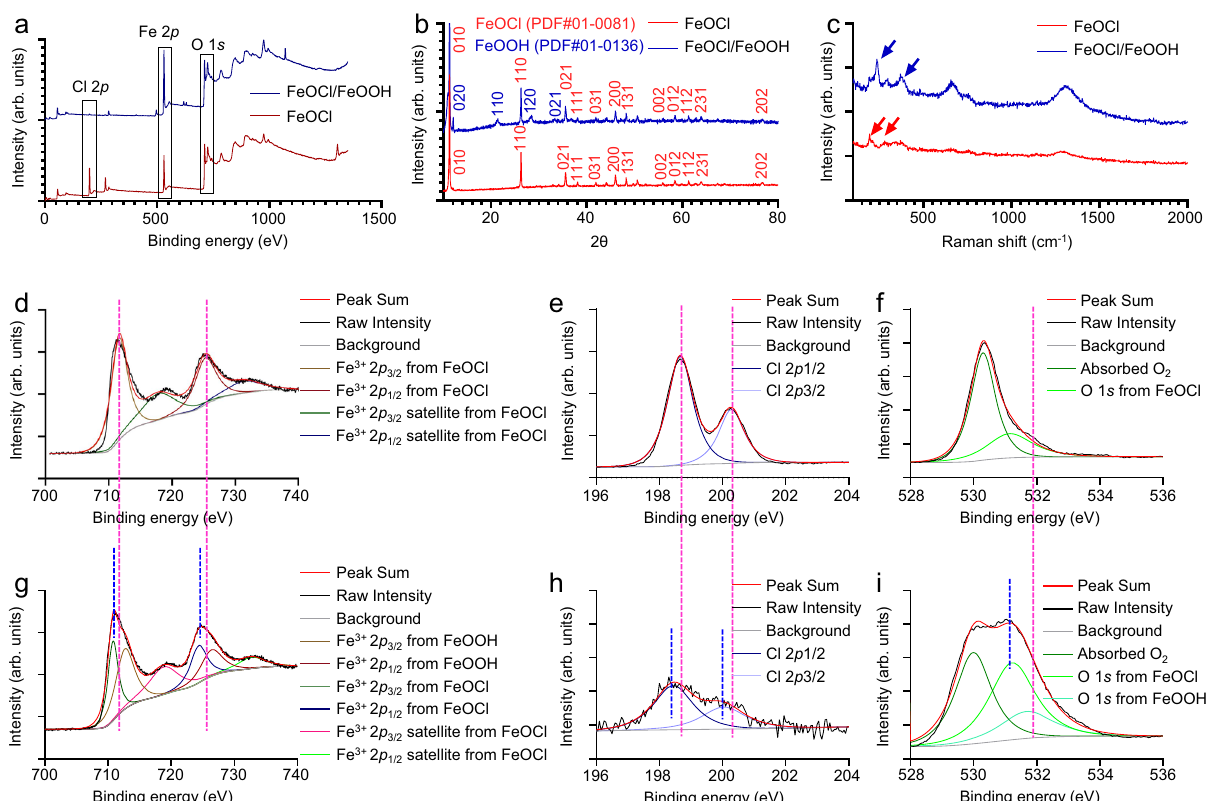
Fig. 3 Chemical composition and structure characterization of layered FeOCl NSs and FeOCl/FeOOH NSs. a XPS spectra of FeOCl NSs and FeOCl/ FeOOH NSs. b XRD spectra of FeOCl NSs and FeOCl/FeOOH NSs. c Raman shift spectra of FeOCl NSs and FeOCl/FeOOH NSs. d , g HRXPS spectra of Fe 2 p in FeOCl NSs and FeOCl/FeOOH NSs. e , h HRXPS spectra of Cl 2 p in FeOCl NSs and FeOCl/FeOOH NSs. f , i HRXPS spectra of O 1 s in FeOCl NSs and FeOCl/FeOOH NSs. For these characterizations of fabricated FeOCl NSs and FeOCl/FeOOH NSs, including XPS, XRD, Raman shift, and HRXPS, three times each experiment was repeated independently with similar results. The units (arb. units) of intensities of XPS, XRD, and Raman spectra mean arbitrary units. Source data are provided as a Source Data fi